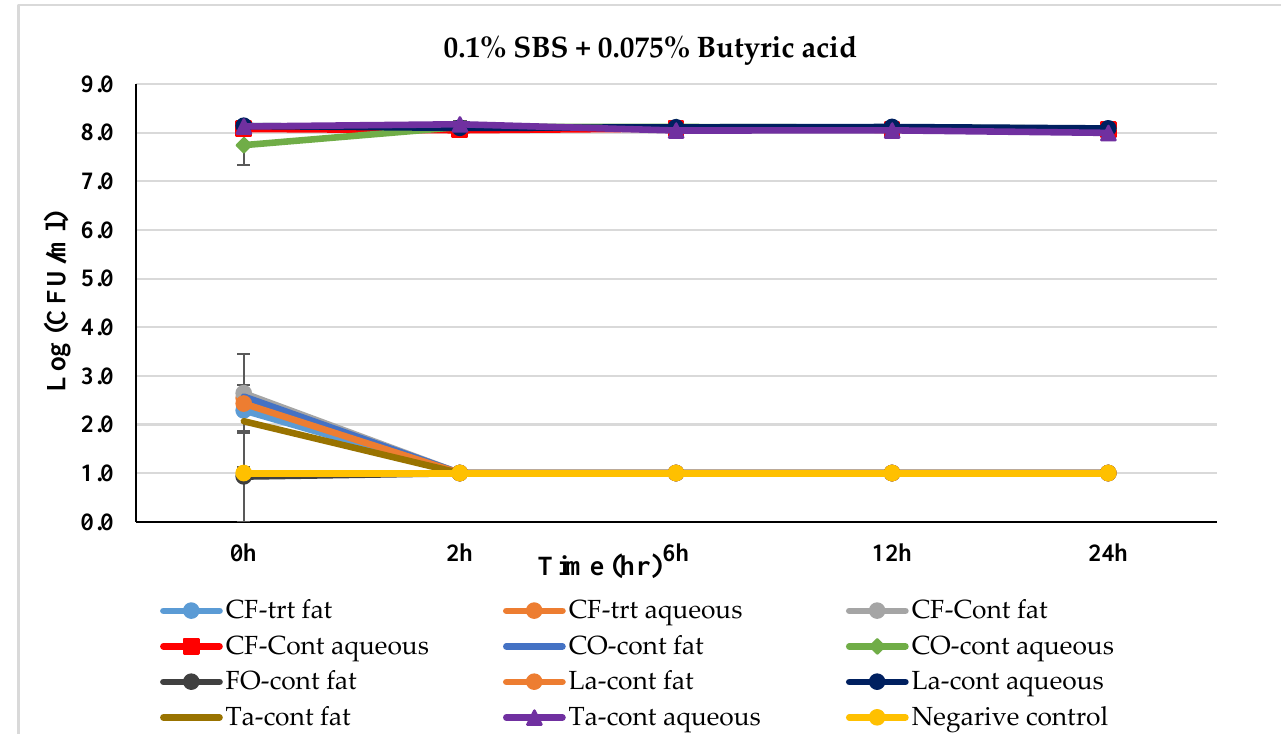
Figure 4. Mean logarithmic counts (log CFU/mL) of Salmonella spp. in different fat and oil systems with and without the inclusion of 0.1% SBS and 0.075% butyric acid evaluated separately for the aqueous phase and fat phase at 45 °C. Treatments from each phase were plated on TSA at different times. SBS, sodium bisulfate; CF, chicken fat; CO, canola oil; FO, fish oil; La, Lard; Ta, Tallow; Cont., control. Negative control consisted of fat-oil system without acidulant and Salmonella inoculation. The limit of detection is 1 log CFU/mL for this study. Because the three replications were averaged, for some of the treatments, the counts on 0 h appeared to be lower-than-detection limit. Error bars are ± 1 standard error of the mean.